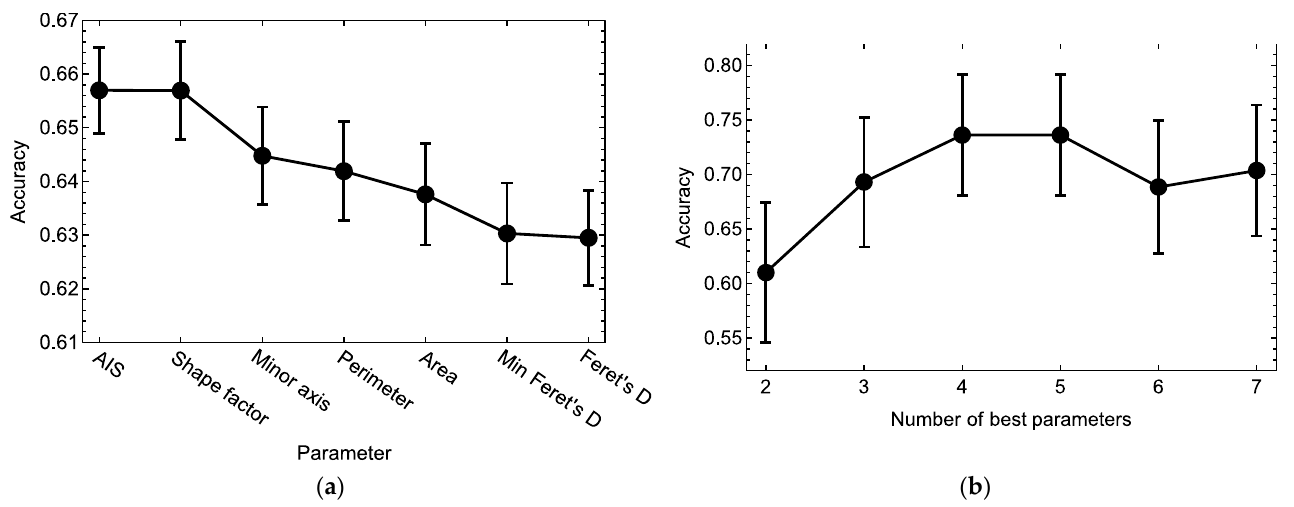
Figure 6. Mean accuracy ± SEM of the phenotype classification models based on different subsets of colony morphological parameters as predictors: ( a ) Importance measure for each parameter calculated as the mean cross-validation accuracy across the models containing this parameter in all possible combinations with all other parameters. Higher values of this measure for a parameter indicated that models containing this parameter as a predictor better recognized the colony phenotype. ( b ) Mean cross-validation accuracy of the models containing a given number of the best parameters from ( a ). Combinations of best parameters in ( b ): 2, AIS and Shape factor; 3, AIS, Shape factor and Minor axis; 4, AIS, Shape factor, Minor axis, and Perimeter; 5, AIS, Shape factor, Minor axis, Perimeter, and Area; 6, AIS, Shape factor, Minor axis, Perimeter, Area, and Min Feret’s D; 7, all parameters. The maximum accuracy in ( b ) was already achieved with four parameters, so the classification model with the four best parameters used as predictors provided a compromise between simplicity and prediction accuracy.